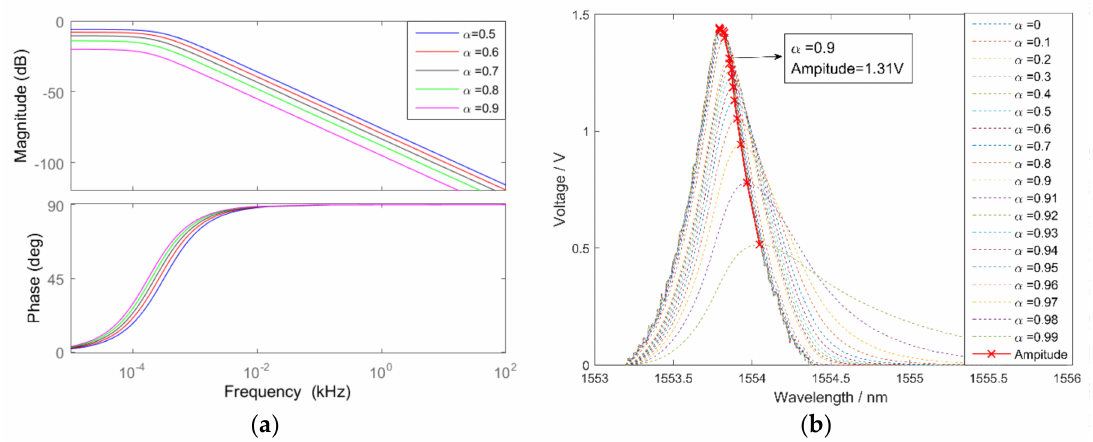
Figure 6. The effect of the first order lag filter: ( a ) the bode plot of the first order lag filter; and ( b ) the peak amplitude after filtering with different α .